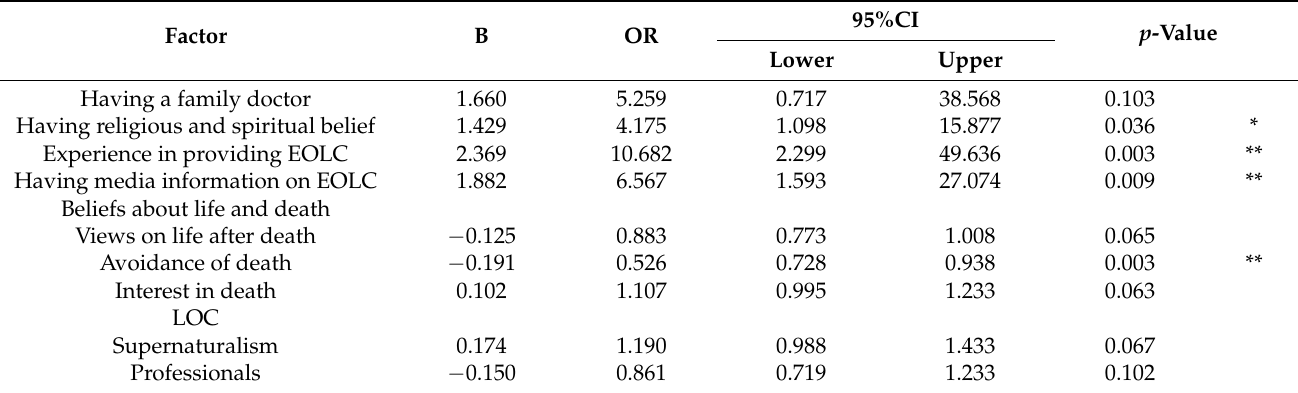
Table 4. Personal and sociodemographic factors that affect behavioral intention (intention to discuss